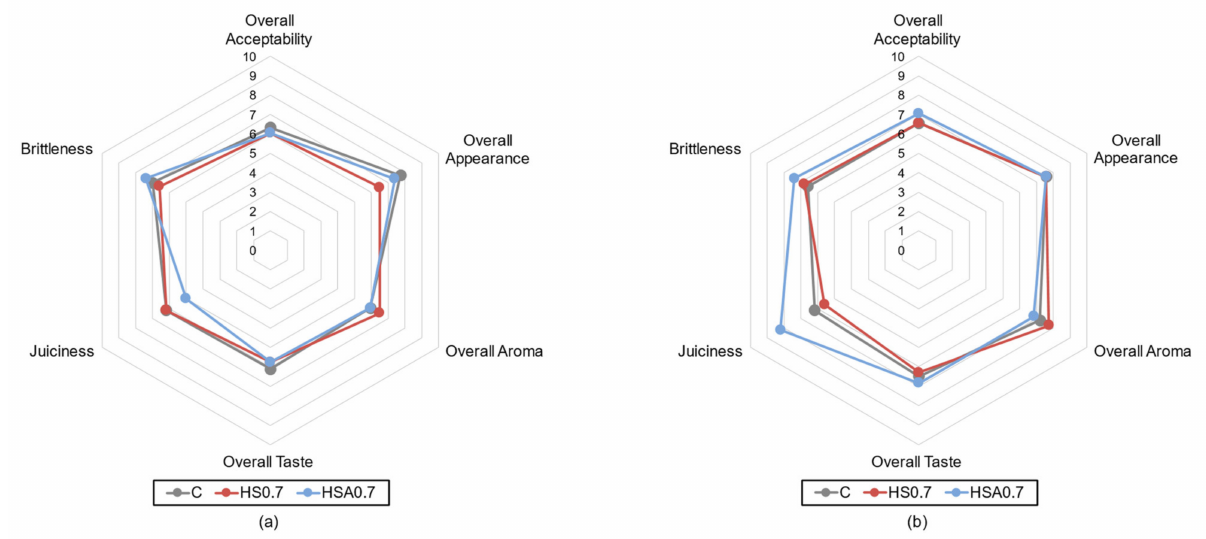
Figure 1. ( a ) The results of sensory evaluation of breast meat samples on the 1st day of storage. ( b ) The results of sensory evaluation of breast meat samples on the 7th day of storage. C: control group; HS0.7: broilers’ diet supplemented with 0.7% of dietary natural HS; and HSA0.7: broilers’ diet supplemented with 0.7% of HS acidified with formic